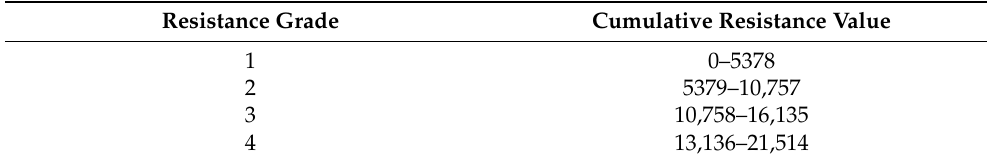
Table 7. Classification criteria of the landscape cumulative